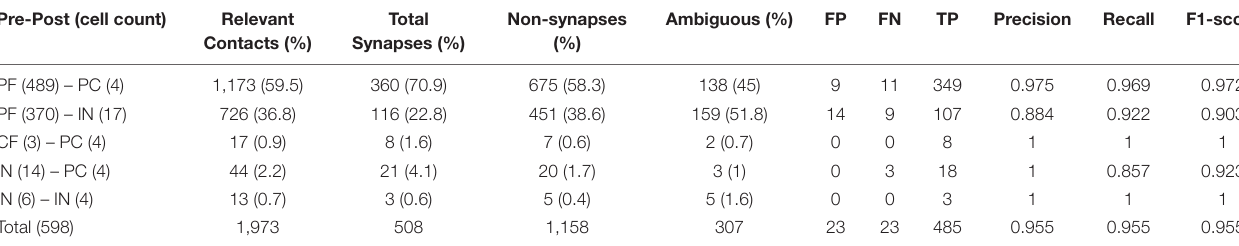
TABLE 3 | Accuracy for the test set by cell type.